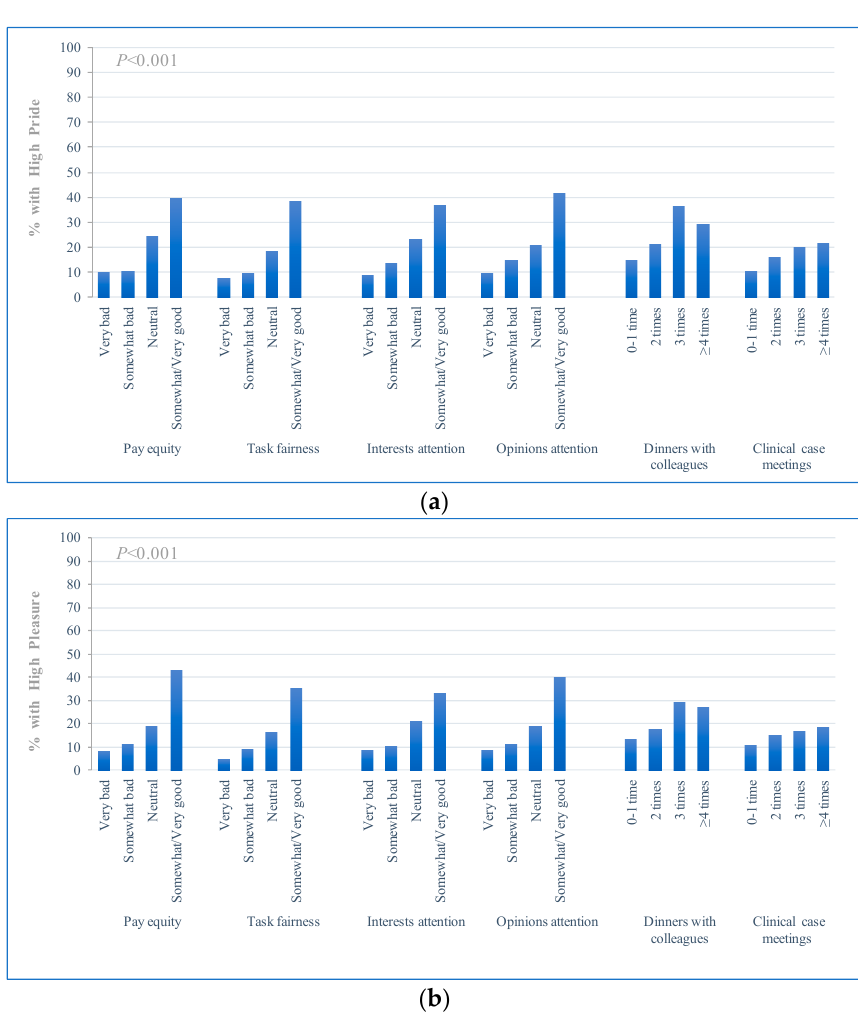
Figure 1. Organizational behavior with work engagement of physician. ( a ) High pride; ( b ) high pleasure.